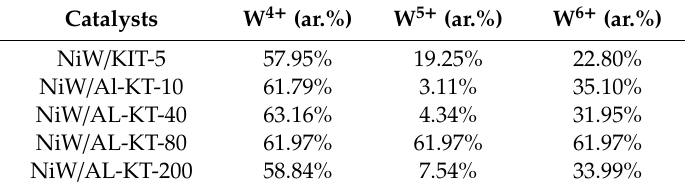
Table 4. Respective proportions of the W species obtained from decomposition of W 4f spectra of NiWS sulfide catalysts.